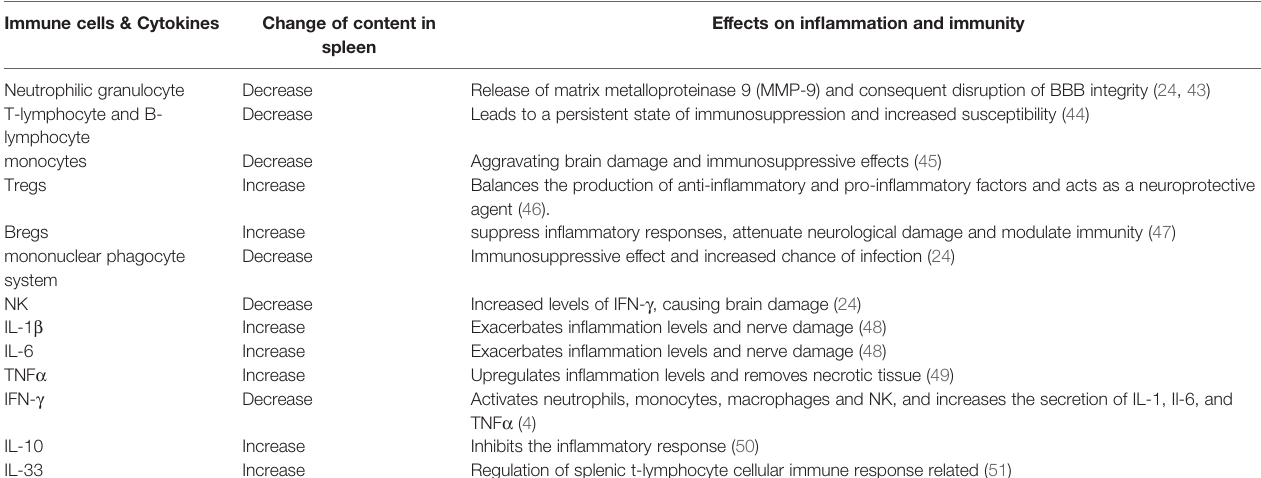
TABLE 1 | Immune cells and cytokines associated with the